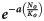
Proportion of free-roaming cats adopted off the street.The annual proportion of free-roaming cats adopted off the street (black line, right axis) was a product of two relationships: the proportion of cat owners that will seek to adopt a free-roaming cat and the proportion of free-roaming cats that are available to be adopted. The proportion of cat owners that will seek to adopt a free-roaming cat exponentially decreases as e-a(NoKo) where a = 1.20397, No is the number of owned cats and Ko owned cat carrying capacity increases (blue line, left axis). The proportion of free-roaming cats that are available to be adopted (i.e. given temperament, personality and need for resources) is a logistic relationship of the form ea(NfKf)+b1+ea(NfKf)+b where a = 3.87637, b = −5, Nf is the number of free-roaming cats, and Kf is free-roaming cats carrying capacity (yellow line, left axis). The dotted line is the value from New et al. [68] that found 0.243 of owned cats were acquired as strays and was used as a guide point to build the logistic function and assumes the system studied by New et al. [68] was at equilibrium (black dot).